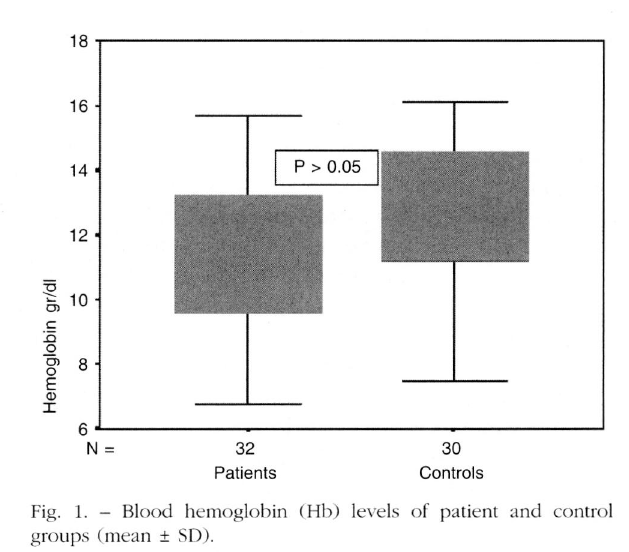
Fig. 1. - Blood hemoglobin (Hb) levels of patient and control groups (mean ±